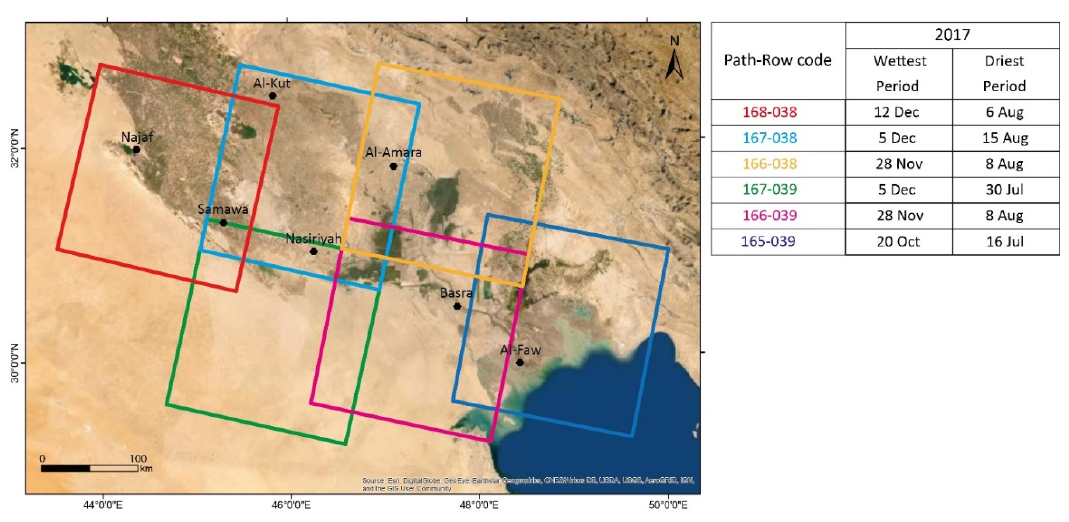
Figure 3. The tiles of Landsat 8 available for the LMP. The tiles are identified by their Path-Row code in the table, specifying the acquisition date for the wettest and driest period.